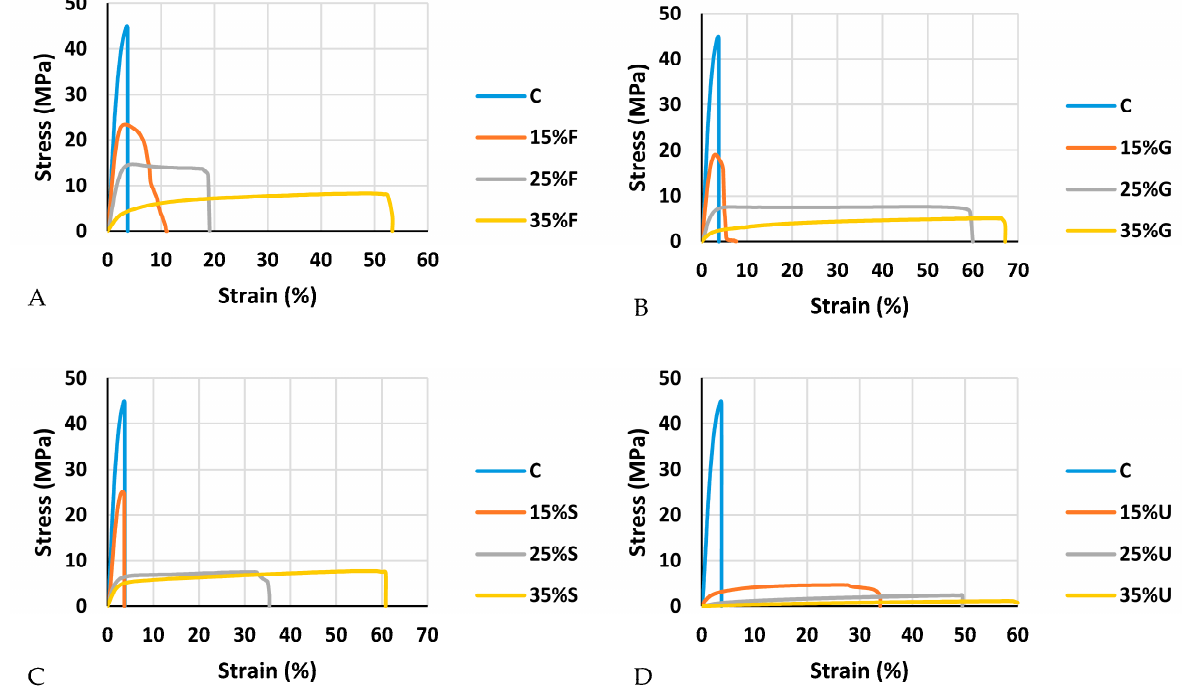
Figure 11. Stress–stain curves of wheat starch-based film with different plasticizers. ( A ) Fructose, ( B ) Glycerol, ( C ) Sorbitol and ( D ) Urea.